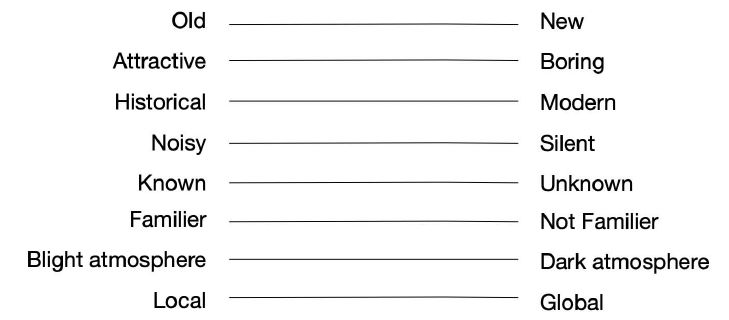
Figure 22. Questionnaire about the image of Nikko.